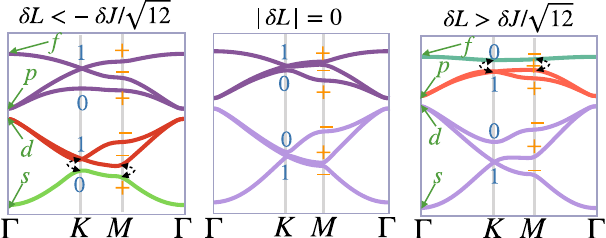
FIG. 14. Three different phases for the graphene TB model with next-nearest-neighbor hopping. For δ J > 0 , j δ L j ¼ 0 the folded graphene band structure is split into two kagomelike band ffiffiffiffiffi p 12 structures (central panel). For δ L < − δ J= , after band-inver- sion transitions at both the M and K points (the orbitals that are exchanged are marked by dashed lines), the lower kagome bands split into a triangularlike s band and a pair of topological bands ffiffiffiffiffi p 12 (left panel). For δ L > δ J= , similar band inversions lead to the splitting of the higher kagome bands into a topological pair of bands and triangularlike f band (right